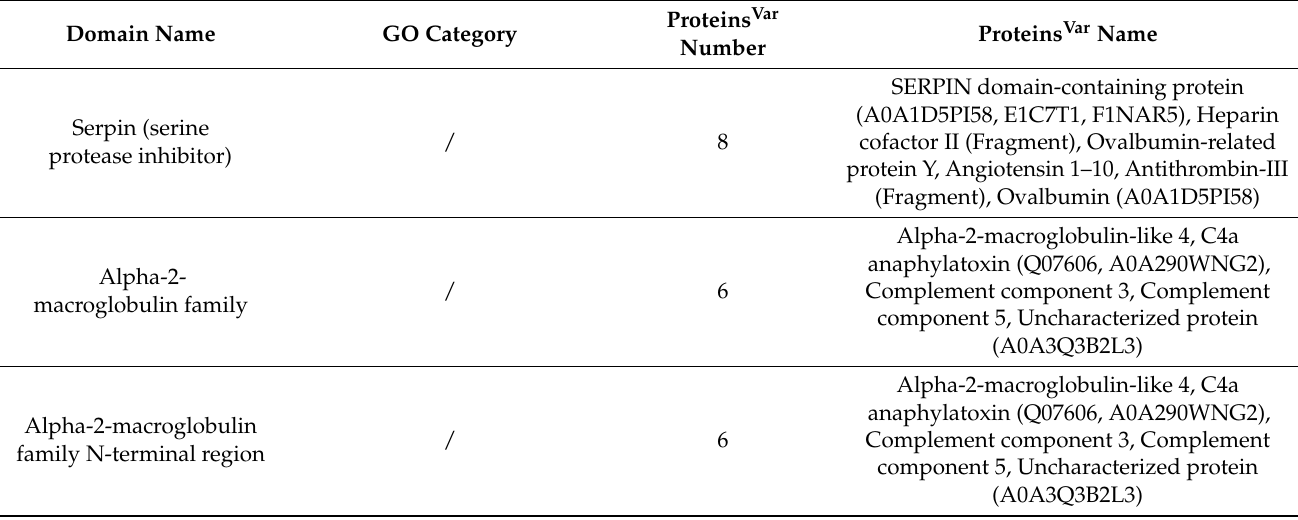
Table 2. List of domains and GO categories contained in Proteins Var